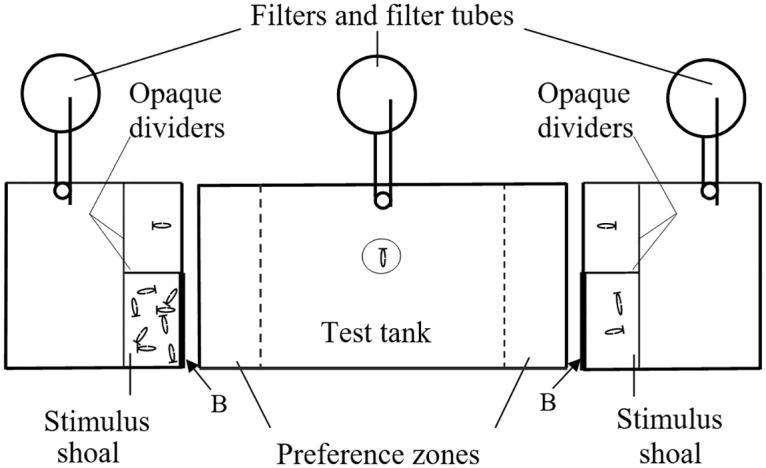
The experimental apparatus.Top view of the experimental apparatus showing the central test aquarium and the two stimulus aquaria, one on each side of the test aquarium. In the stimulus aquaria, opaque dividers were used to isolate a 10-cm compartment where the stimulus shoals were placed. An additional opaque piece divided this compartment in half: in one half, a stimulus angelfish was placed, and in the other the rest of the members of the stimulus shoals. Opaque barriers (B) were used to hide the stimulus shoals from the test fish during the pretest phase (for 2 sec in Experiment 1, and for 15 sec in Experiment 2). Then, the barriers were moved backwards so as to present a single stimulus fish on both sides while the rest of the members of the stimulus shoals was kept hidden. The time the test fish spent within the 10 cm of the stimulus (preference zones) was recorded. Modified from [45].